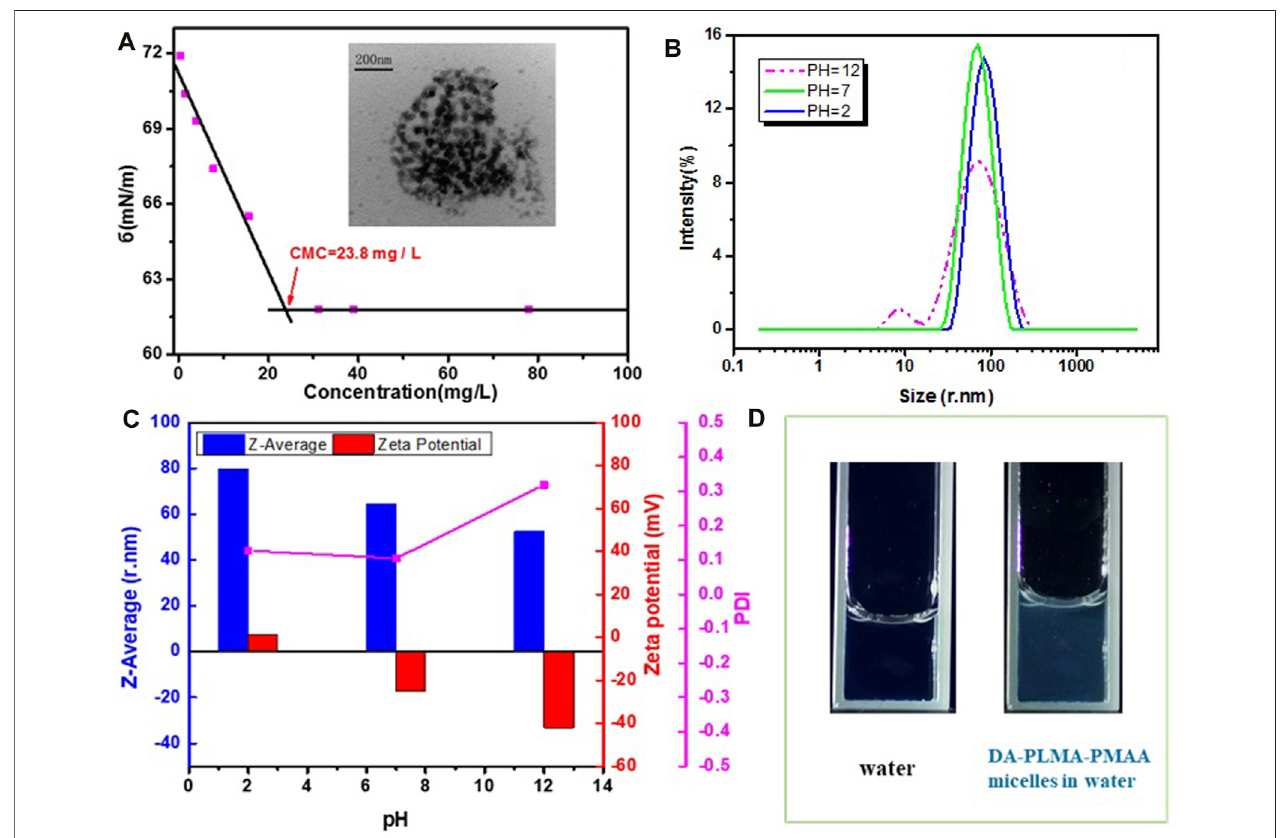
FIGURE 6 | (A) TEM image of micelles (inset image) and surface tension vs. micelle concentration at pH (cid:2) 7; (B) size distribution pro fi les by intensity of micelles in different pHs; (C) Z-average, PDI, and zeta potential of micelles in different pHs; and (D) fl uorescence spectra of water and DA-PLMA-PMAA micelles in water (digital photograph taken under 365